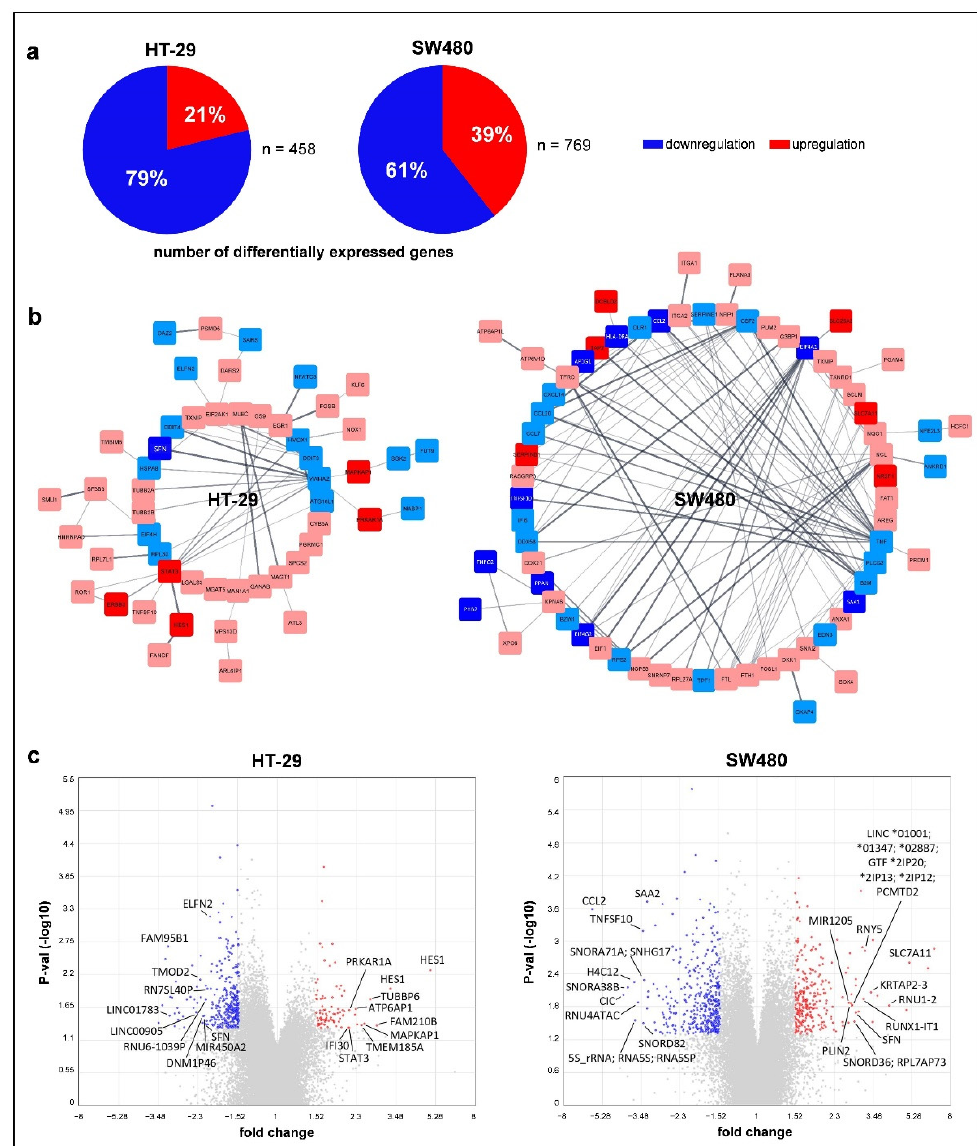
Figure 4. Genome-wide transcriptome alterations of HT-29 and SW480 cells following 10,000 ng/mL folic acid (FA) supplementation detected by Human Transcriptome Array 2.0 (HTA 2.0). ( a ) Pie charts represent the proportion of up- and downregulated genes. ( b ) Visual networks of protein–protein interactions were generated by the StringApp of Cytoscape software based on the list of genes with significant ( p ≤ 0.05) expression alterations and ≥ |1.5| fold change (FC). Colors refer to the expression level of protein-coding genes (dark blue: FC ≤ − 2, light blue: FC ≥ − 2 and ≤ − 1.5, light red: FC ≥ 1.5 and ≤ 2, dark red: FC ≥ 2). ( c ) Top 10 genes showing significant ( p ≤ 0.05) up- and downregulation visualized with volcano plots. Gray points represent all the transcripts detected by HTA 2.0 microarray, while significantly ( p ≤ 0.05) altering genes with FC ≥ |1.5| value were marked with red and blue. P-val: p -value.